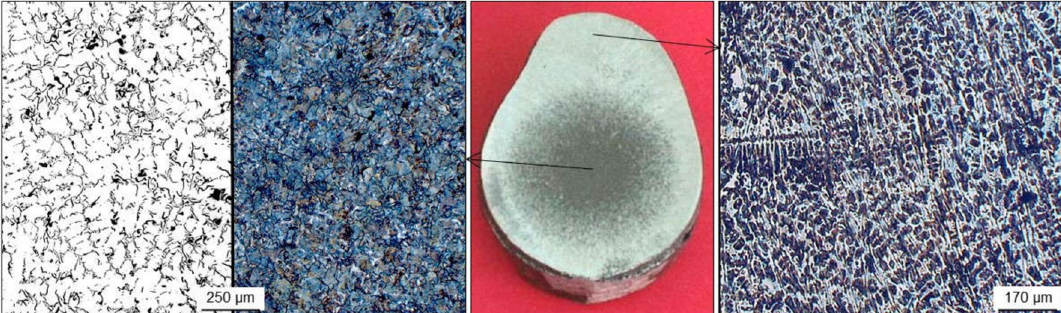
Figure 89. Cross section of a grey iron camshaft showing different